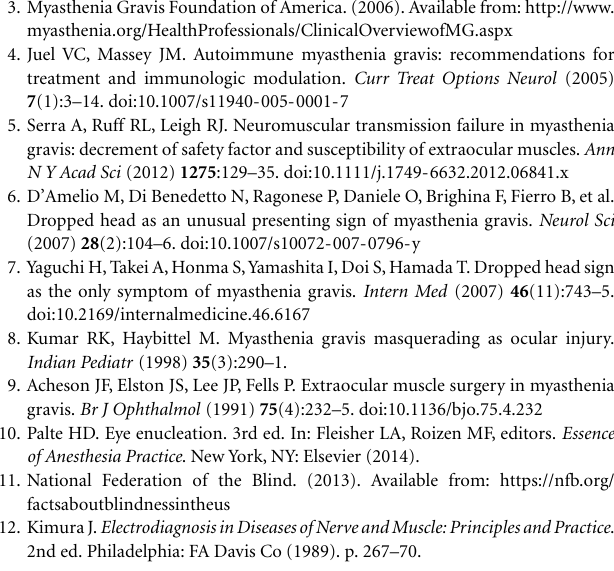
ConflictofInterestStatement: Theauthorsdeclarethattheresearchwasconducted in the absence of any commercial or financial relationships that could be construed as a potential conflict of